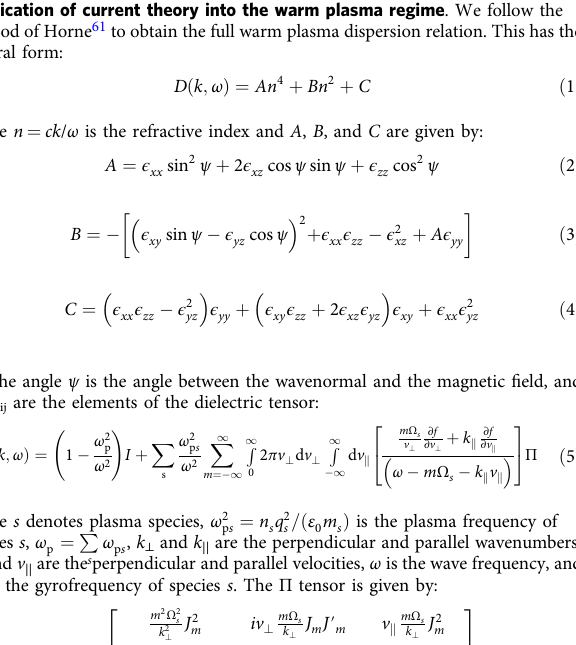
spatial resolution (500m at zenith) of MOOSE, in comparison to other all-sky imagers, such as the white-light THEMIS All-Sky Imagers (ASIs) 60 allows the aurora to be signi fi cantly better characterised in this study. The data were calibrated using techniques outlined in Grubbs et al. 23